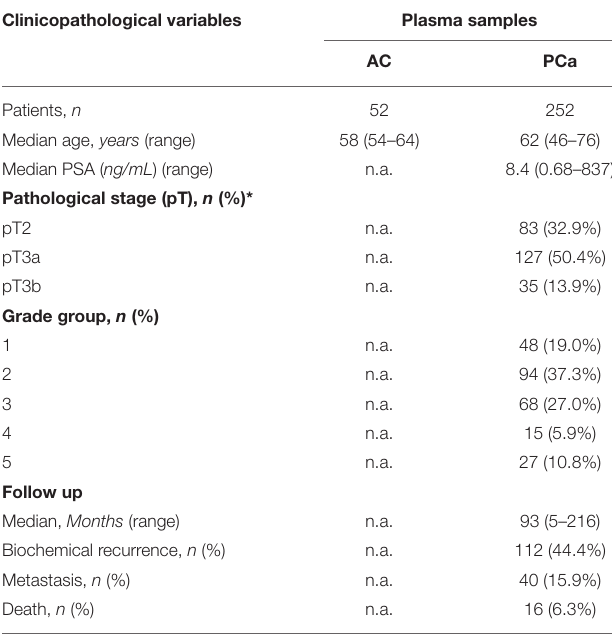
TABLE 2 | Clinical and pathological data of asymptomatic controls and prostate cancer patients (Cohort